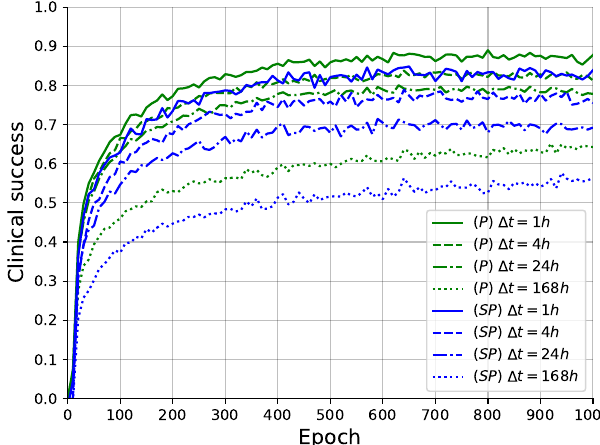
Figure 3. The RNN models’ performance over the learning process. Each series denoted a different level of temporal discretization. Green series, denoted P, represent the personalized version of the RNN and the blue ones, denoted SP, represent the semi-personalized version. Table 2. A comparison between the proposed Personalized and Semi-personalized RNN models with the two baseline model’s Morales et al. [7] and Guzev et al. [22]. The results are shown as mean ± standard deviation. Recall, b 0 and i 0 are the standard BCG and IL-2 injection amount proposed in